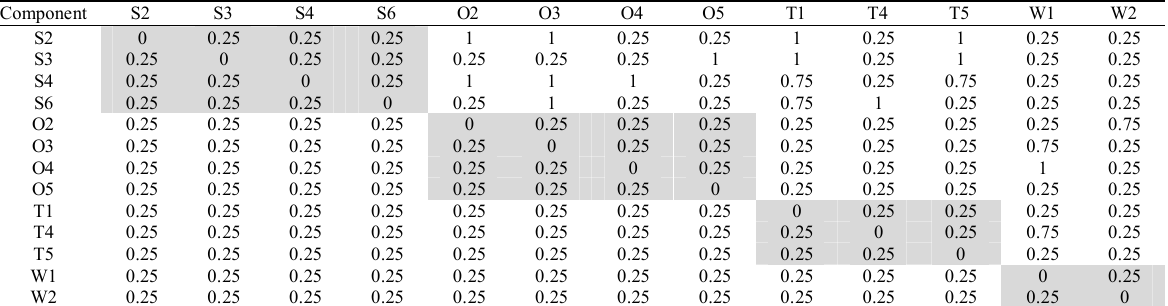
The summary for Component